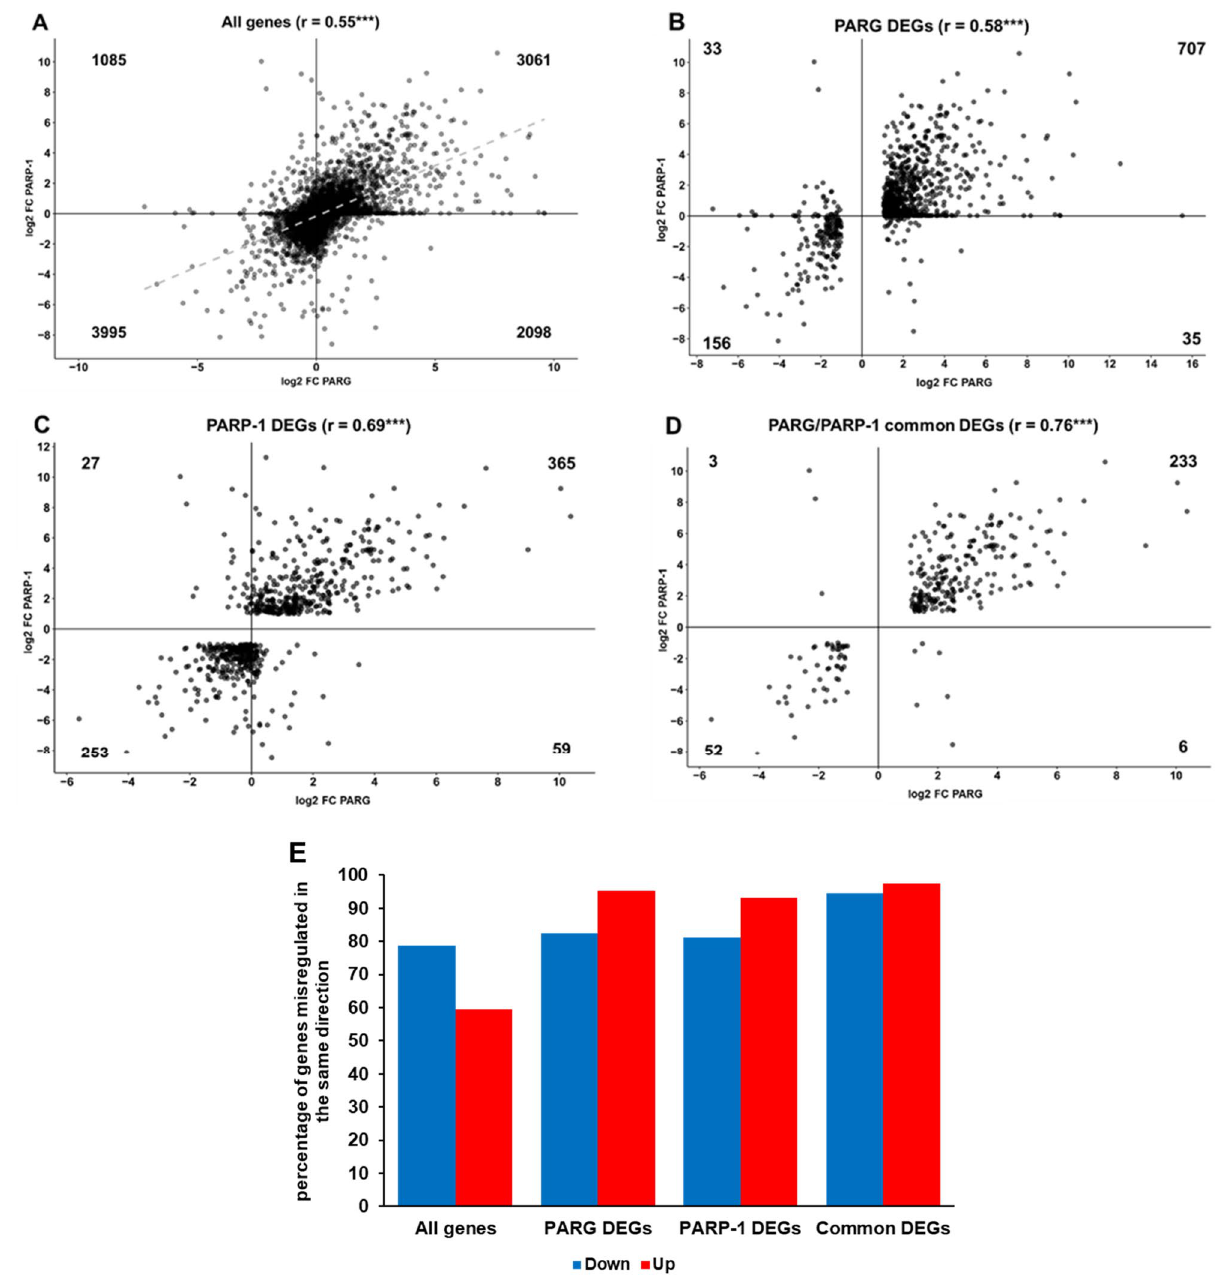
Figure 3. Parp-1 and Parg mutants present similar changes in their expression profiles. ( A - D ) Scatter plots representing the expression of ( A ) 10 239 genes expressed in both Parp-1 and Parg mutants, ( B ) 931 PARG DEGs expressed in Parp-1 mutant, ( C ) 704 PARP-1 DEGs expressed in Parg mutant, and ( D ) 294 PARP-1/ PARG common DEGs. X-axis shows a log2 scale of Fold Change (FC) in the absence of PARG compared to control, while Y-axis shows a log2 scale of FC in the absence of PARP-1 compared to control. The number present in each quadrant corresponds to the number of genes present in this quadrant. The r number is the Pearson correlation coefficient. The p -value is calculated based on the Pearson correlation coefficient and the t-distribution with n-2 degrees of freedom. *** p < 0.01. ( E ) Summary of the data represented in ( A – D ). Genes downregulated in both mutants are represented in blue, while genes upregulated in both mutants are represented in red. This graph is a comparison between X- and Y-axis presented in ( A – D ). For example, the red bar in the “All genes” category means that 59.3% of the genes expressed in both mutants and upregulated in the Parg mutant are also upregulated in the Parp-1